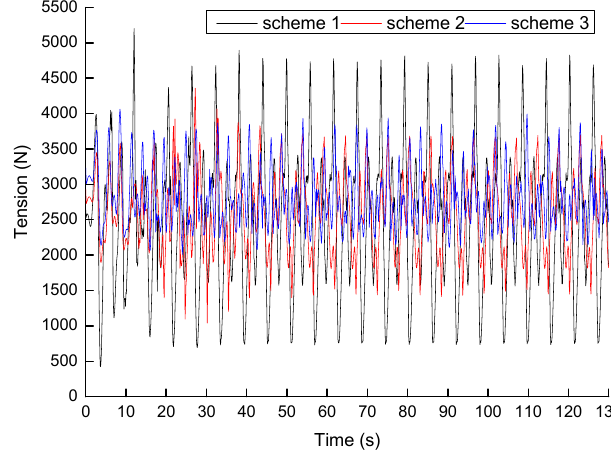
Figure 8. The stress of anchor chain 3 in schemes 1, 2, and 3.